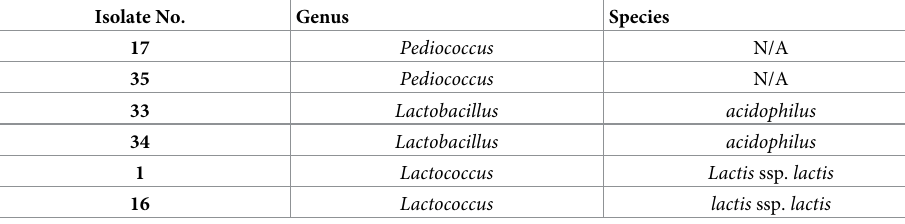
N/A, data obtained were enough only for the identification of the genus